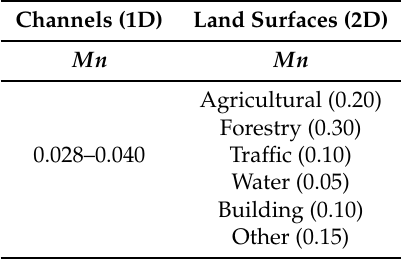
Table 2. Additional parameters used for WASH123D simulations in the